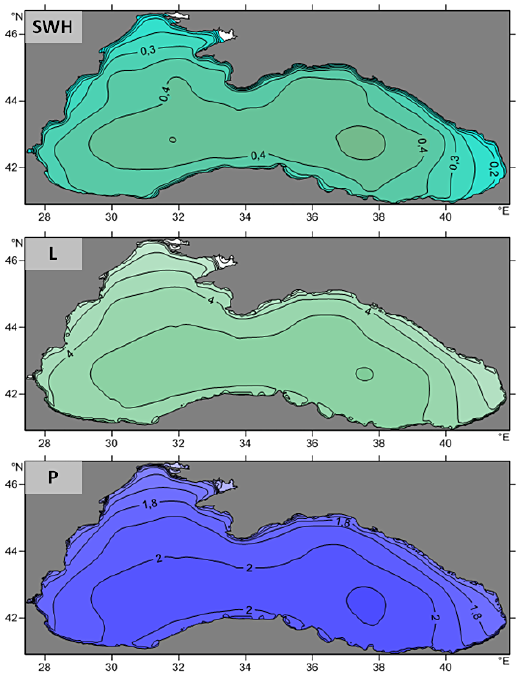
Figure 5. Maps of calculated average significant wave height [m], wave length [m] and period [s] in winter.